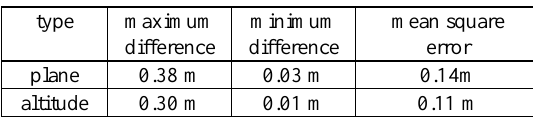
Table 6. statistics of differential static observation